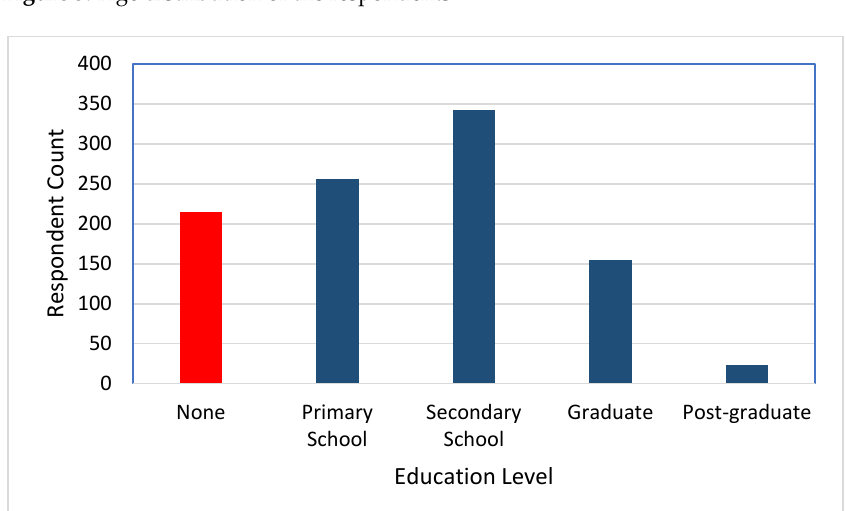
Figure 5. Age distribution of the respondents.